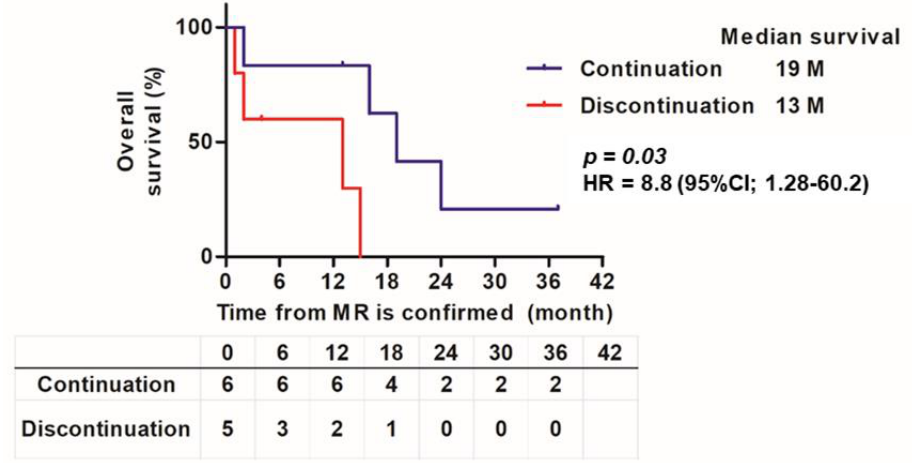
Figure 6. Kaplan–Meier curve of pembrolizumab continuation group and discontinuation group after MR confirmation. Kaplan–Meier estimates of overall survival according to pembrolizumab continuation and discontinuation from when MR was confirmed to the date of death by any cause. In the discontinuation group, pembrolizumab was discontinued and standard treatment (chemotherapy and best supportive care) was provided.